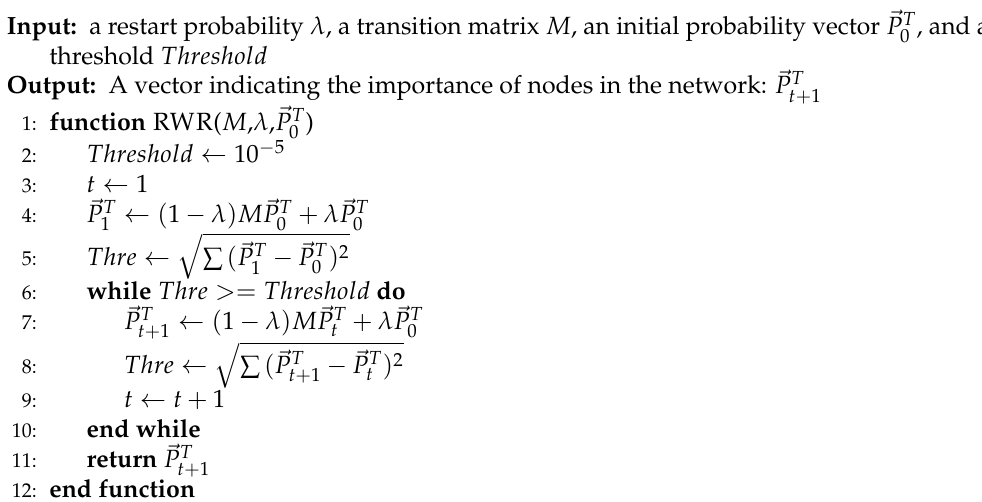
Algorithm 1 Random Walk with Restart